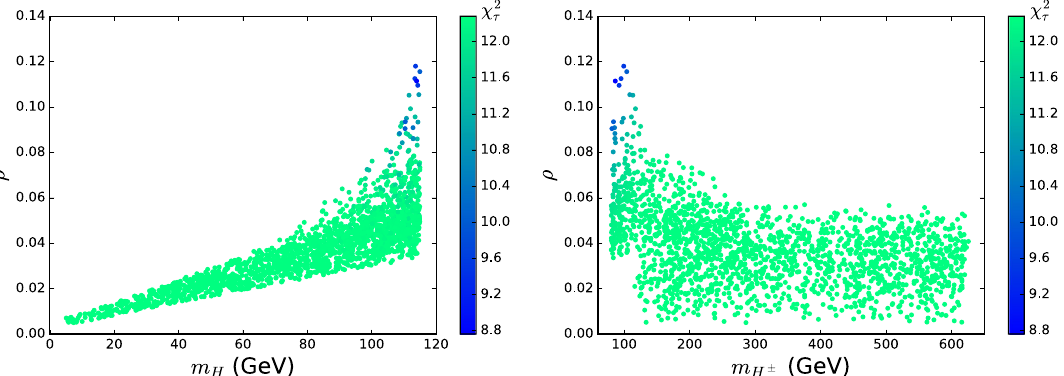
Fig. 3 The surviving samples satisfying the constraints of ”pre-muon g − 2”, muon g − 2 anomaly, χ 2 τ < 12.3, and Z decays